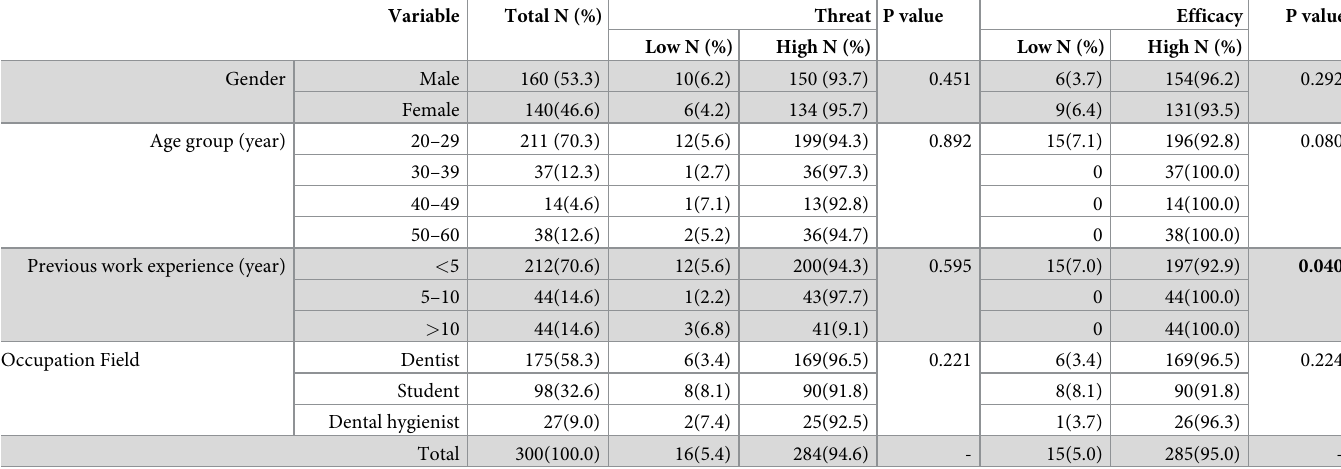
Table 2. Associations between respondents’ demographic characteristics and perceived threat and efficacy to COVID-19